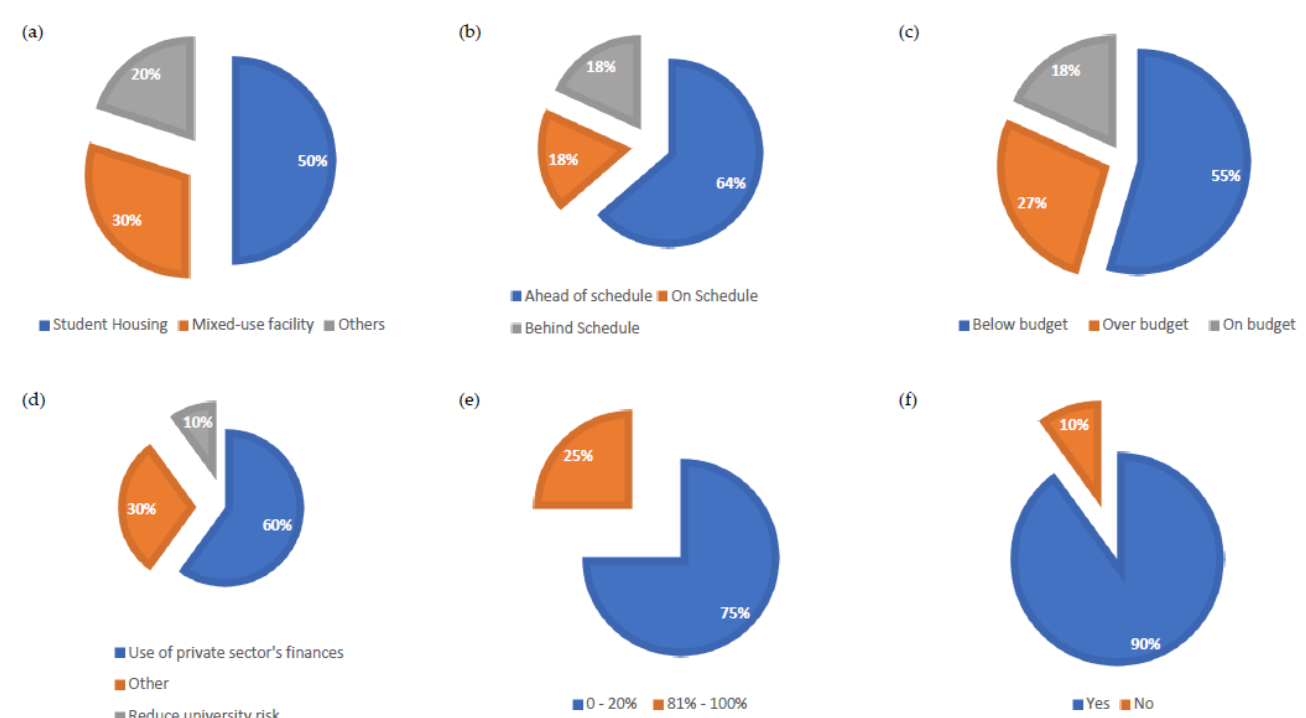
Figure 3. Statistical summary of some of the results of the questionnaire survey: ( a ) project purpose, ( b ) project status according to schedule, ( c ) project status according to cost, ( d ) reasons for adopting PPPs, ( e ) % of financing provided by university, ( f ) whether the expert will adopt PPP in the future .